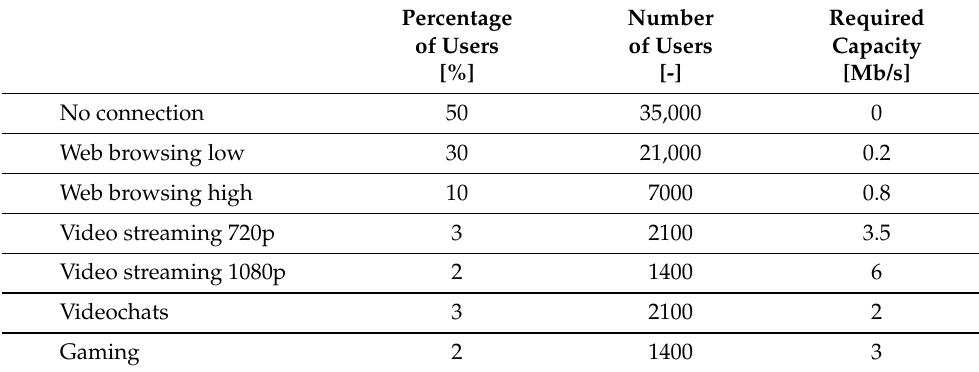
Table 3. Traffic mix distribution among